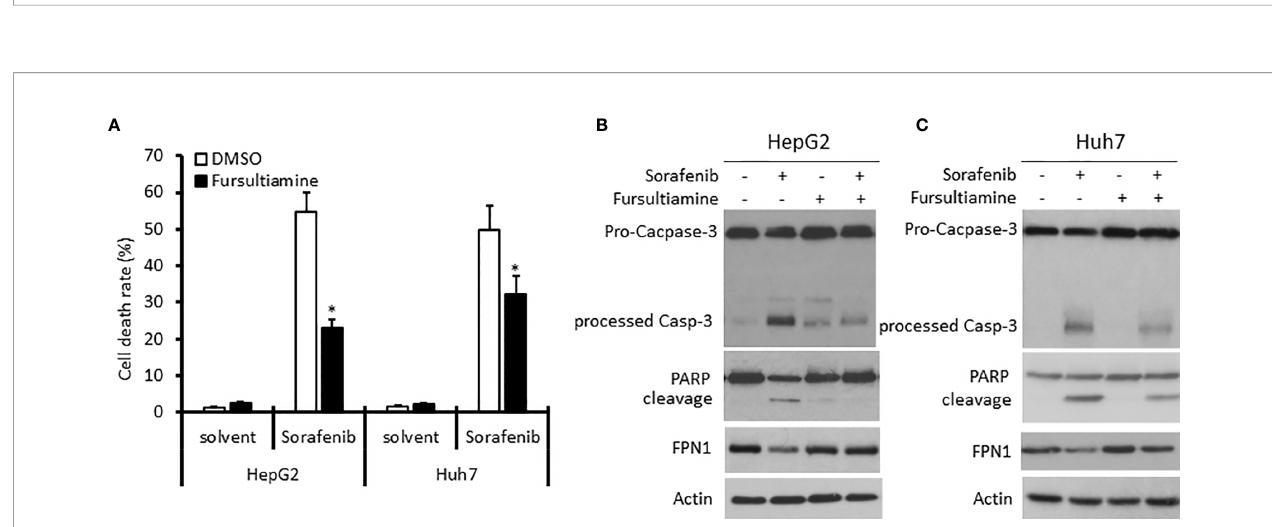
FIGURE 7 | Hepcidin antagonist pretreatment reduces Sorafenib-induced cell death in HCC cells. HepG2 and Huh7 cells were pre-treated with Fursultiamine (10 µM) for 30 minutes, followed by Sorafenib (5 µM) treatment for 24 h. Cells were harvested for trypan blue exclusion assay (A) or western blot assays with the antibodies as indicated (B, C) . Actin blots served as the protein loading control. The asterisk indicates a signi fi cant difference compared to the DMSO control (p < 0.05, Student t -test).